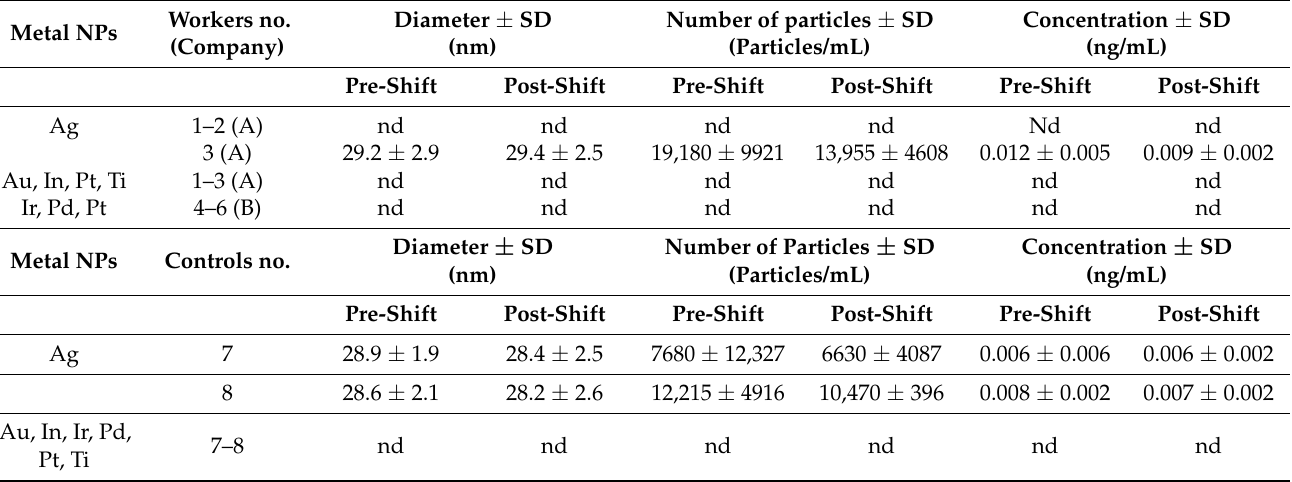
Table 3. Analysis of metal nanoparticles (NPs) in urine of workers from Company A (no. 1–3), Company B (no. 4–6) and controls (no. 7–8), at pre-shift (1st–4th day, mean) and at post-shift (1st–4th day,